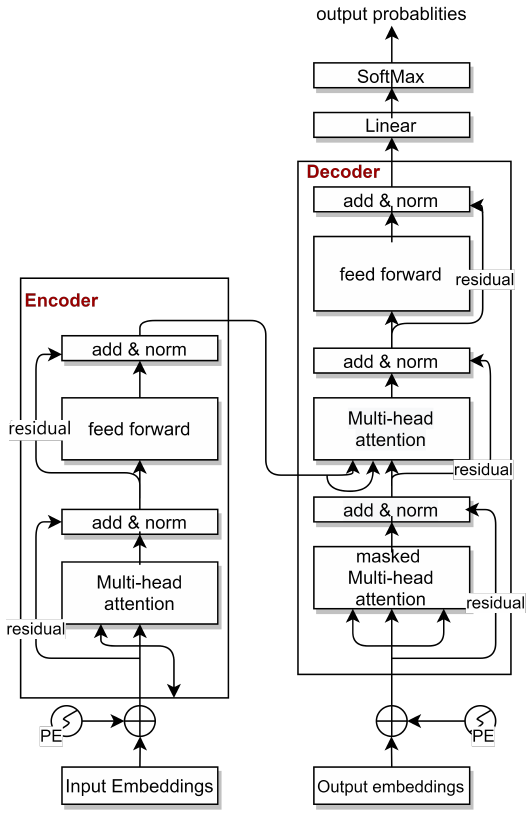
Figure 2. Transformer architecture, multi-head attention layer architecture, and scaled dot-product attention